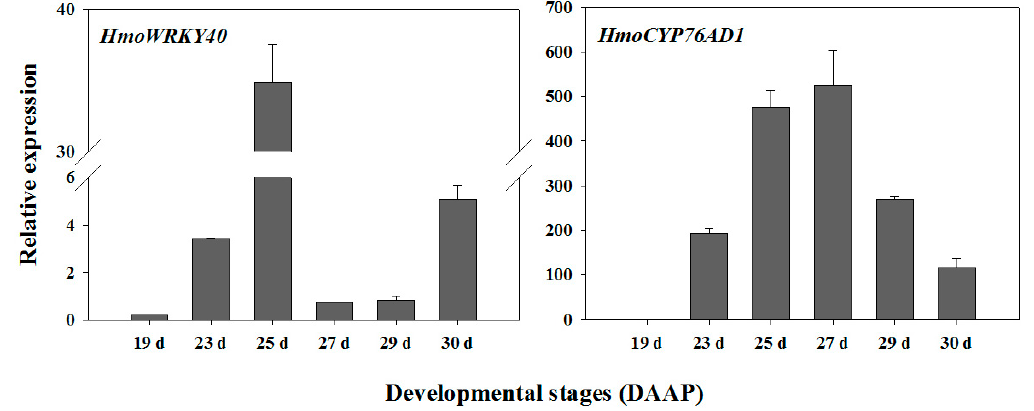
Figure 3. Expression analyses of HmoWRKY40 and HmoCYP76AD1 at all pulp coloration stages of the Guanhuahong pitayas. The expression level of the 19th DAAP was used as the calibrator (set as 1). The data represent the mean values from three biological replicates (±S.D.).